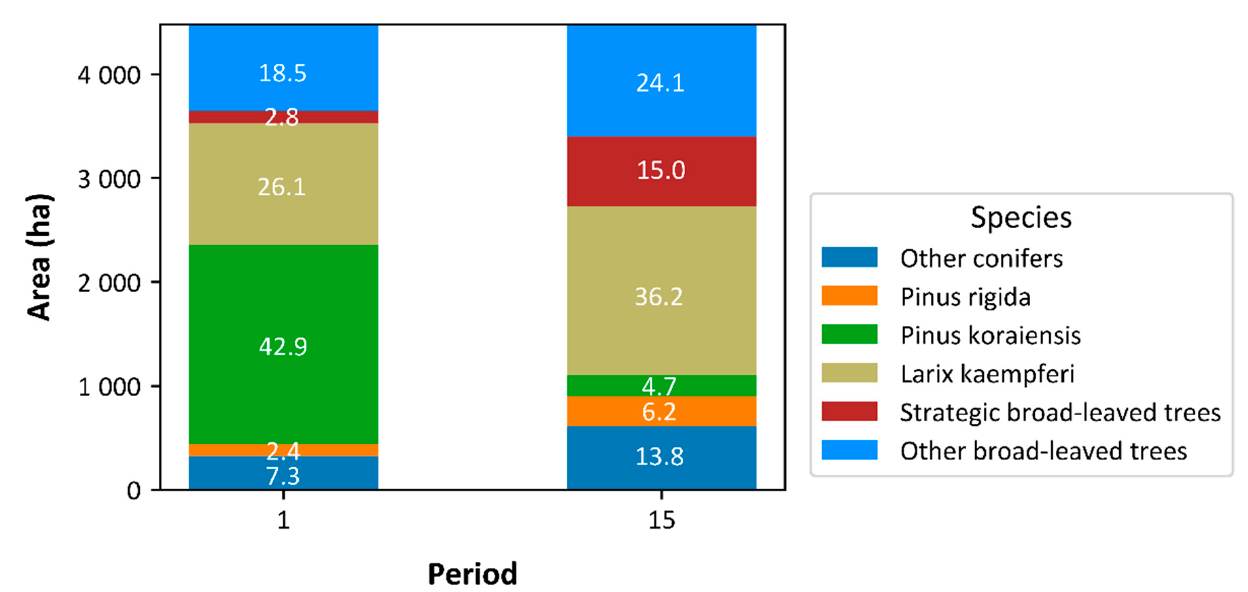
Figure 13. Changes in the tree species composition from the 1st to 15th periods with a 30% timber production variation rate. The numbers in the bar graph indicate the area proportions of each species in the period. Strategic broad-leaved trees denote the species specifically planned to expand afforestation in the forest master plan, including Fraxinus rhynchophylla , Juglans mandshurica , Cornus controversa , Betula platyphylla , and Fraxinus mandshurica